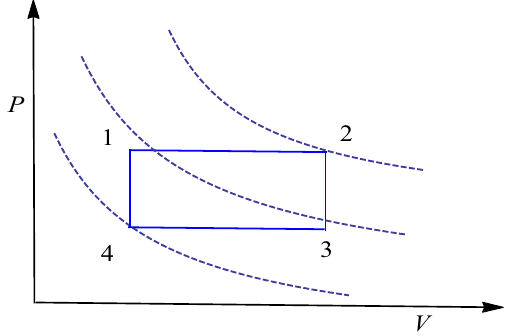
Fig. 3 The engine mainly discussed in this paper. Dashed lines repre- sent the isothermals